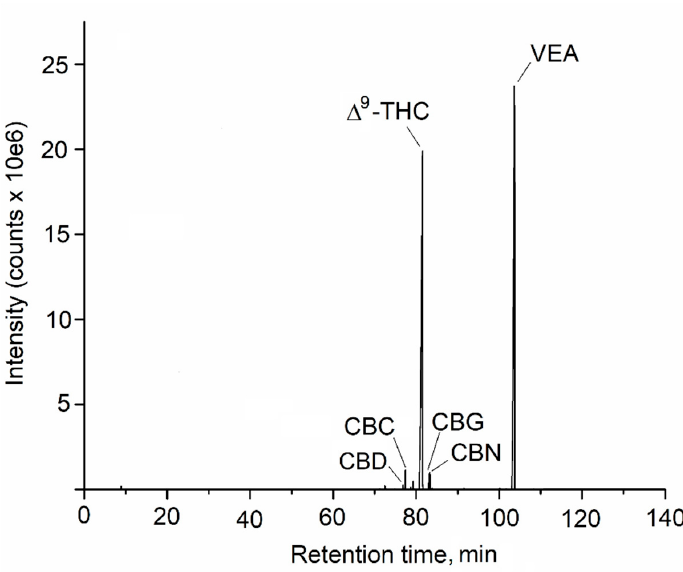
Figure 1. Untargeted analysis of vaporizer fluid using GC-MS identifies VEA. Shown is the TIC chromatogram from the analysis of an EVALI case-associated vaporizer fluid. Identified cannabinoids and VEA are denoted.